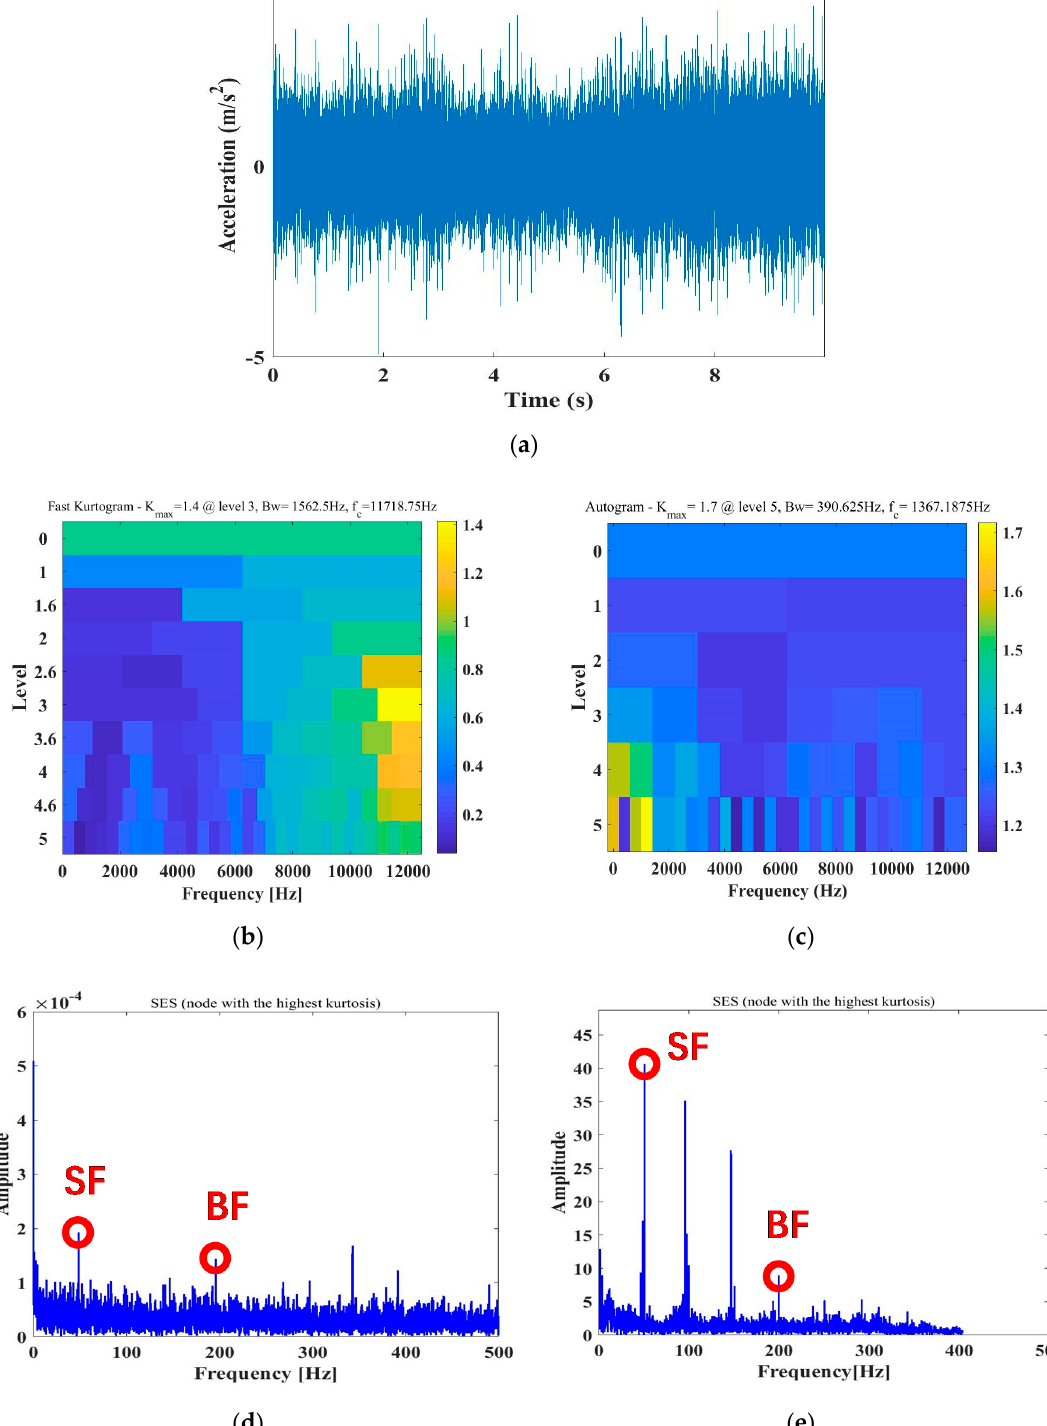
Figure 2. Autogram vs. Kurtogram of pump vibration signals at Status 7 at a 100% flow rate, with real data measured at Sensor 15: ( a ) Acceleration signals of pump vibrations from Sensor 15 at Status 7 at a 100% flow rate; ( b ) Kurtogram of real data. The brightest node indicates the biggest kurtosis; ( c ) Autogram of real data. The brightest node indicates the biggest kurtosis; ( d ) Autogram of real data. The brightest node indicates the biggest kurtosis; ( e ) square-envelope spectrum related to the brightest node.